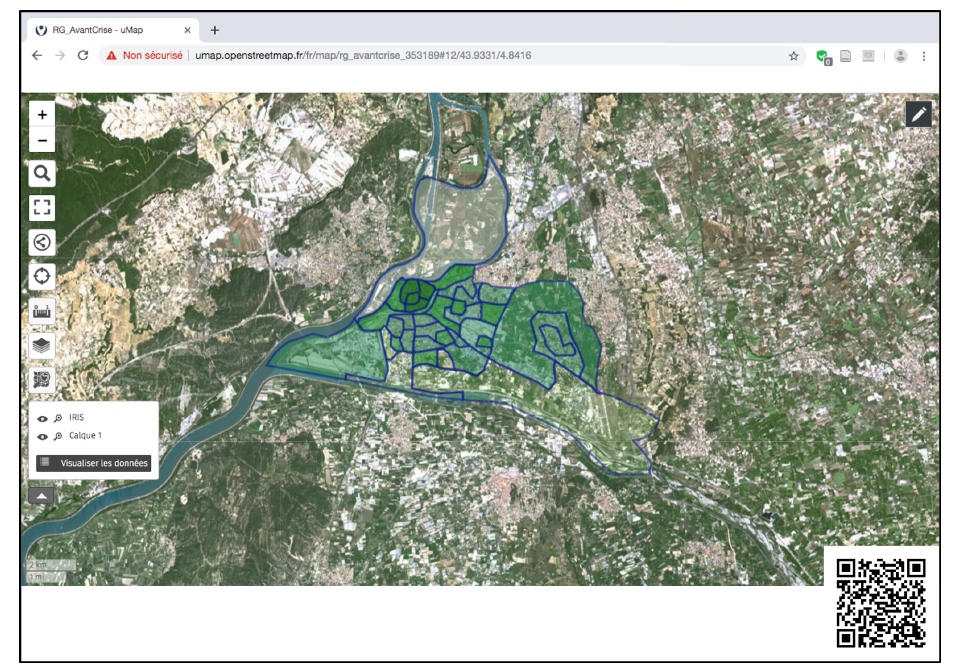
Figure 13. Weblink global resilience – pre-crisis scenario map – QR code – © UMAP-Open Database License, “ODbL”